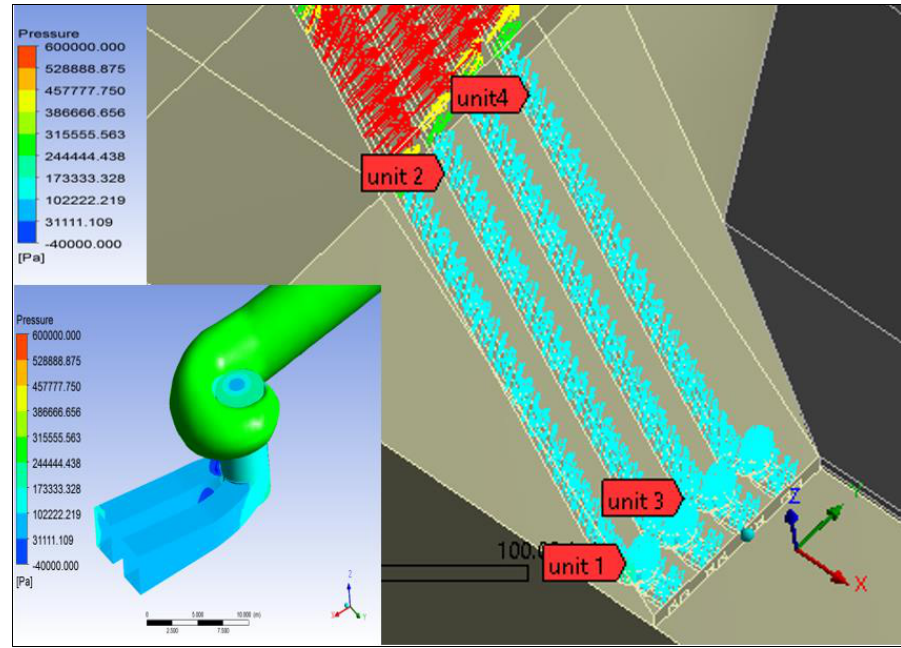
Figure 12. 3D numerical model with transforming pressure from turbine unit to the Temenggor dam model.